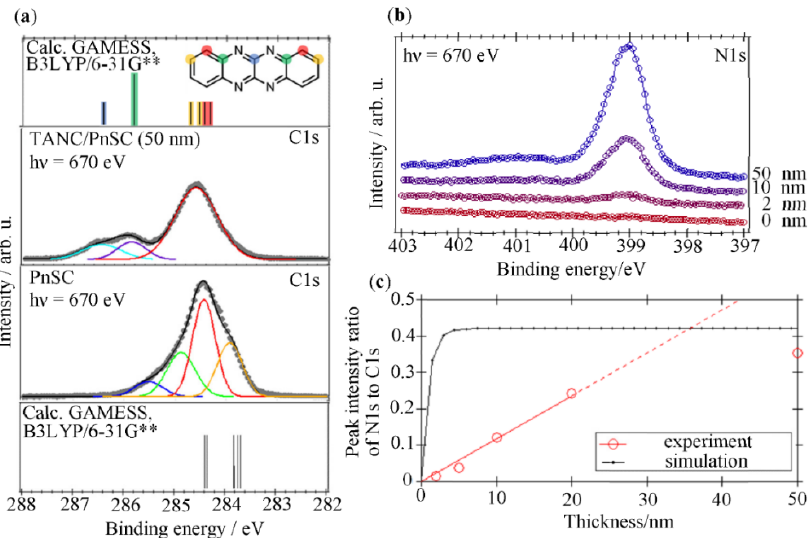
Figure 4. ( a ) C1s XPS spectra of the PnSC and TANC(50 nm)/PnSC interface. Quantum chemical calculation results for the C1s energy level distributions of TANC and pentacene molecules at fixed internal coordinates in the respective molecular crystals are also indicated as vertical bars, where the vertical scale is slid to align the energy position to the experimental peak position. ( b ) Evolution of N1s XPS spectra with increasing TANC thickness (2, 10, 50 nm) on PnSC. ( c ) N1s/C1s intensity ratio in this experiment (circles). A fitting line for the data points at and below 20 nm (red) and an expected ratio under the assumption of the layer-by-layer growth mode for TANC on the PnSC surface (black) are also indicated.